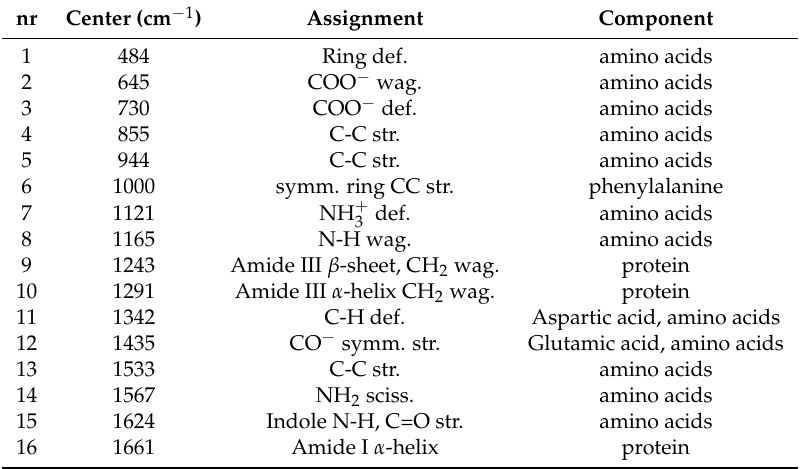
Table 2. Principal contributions in SERS spectrum of human tears and their assignment according to Refs. [12,21,22].